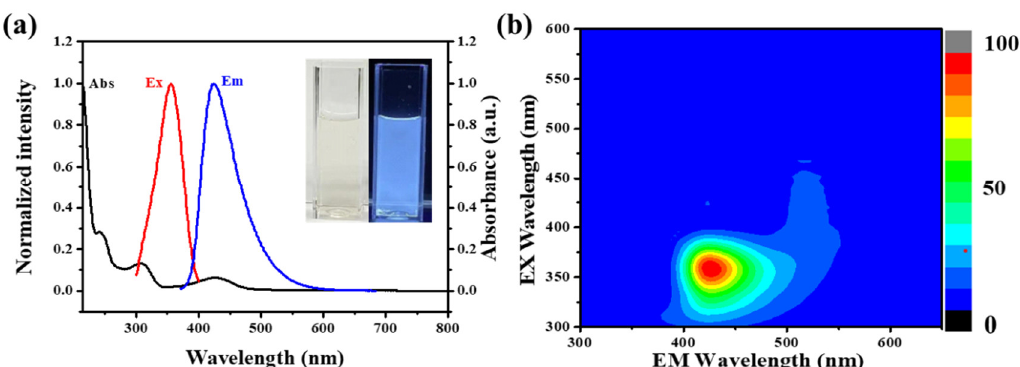
Figure 3. ( a ) Emission spectrum (blue line) under 355 nm excitation, excitation spectrum (red line) under 428 nm emission, and the UV-vis absorption (black dotted line) spectrum of NFCDs. Inset: photograph of the aqueous solution of NFCDs acquired under 365 nm light irradiation. ( b ) 3D spectrum of NFCDs.